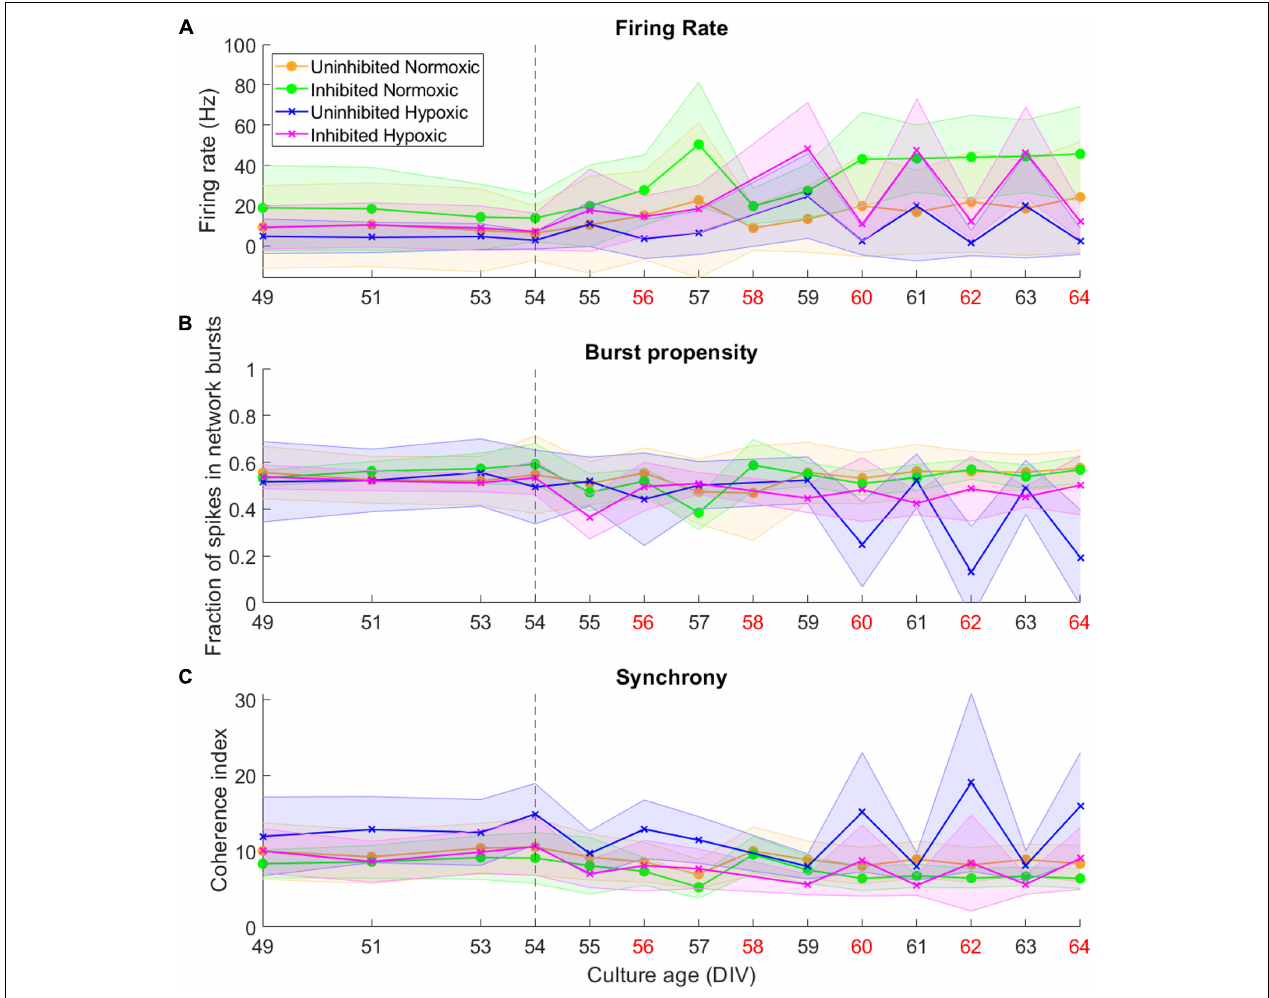
FIGURE 3 | Activity of neural networks before and after the hypoxic challenge. The activity of the motor neuron networks is described in terms of firing rate (A) , fraction of spikes in network bursts, or bursting propensity (B) , and coherence index, a measure of network synchrony (C) . The stippled line at 54 DIV indicates when the hypoxic challenge was carried out, and the data points presented for this day are baseline recordings pre-hypoxia. Red labels along the Culture Age axis indicates that cell media was replaced these days. Lines and shaded regions indicate median ± median absolute